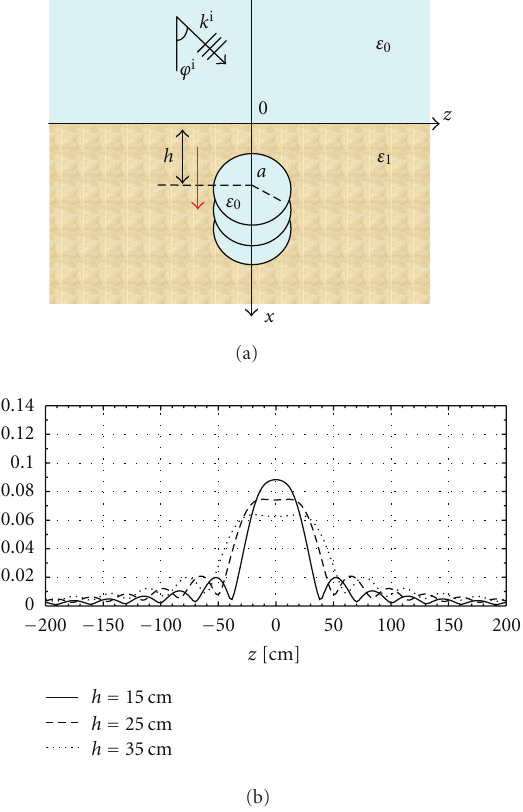
Figure 8: Total scattered field in air, along a line parallel to the interface, for air cavities of di ff erent size. Figure 9: Total scattered field in air, along a line parallel to the interface, for air cavities located at various depths.